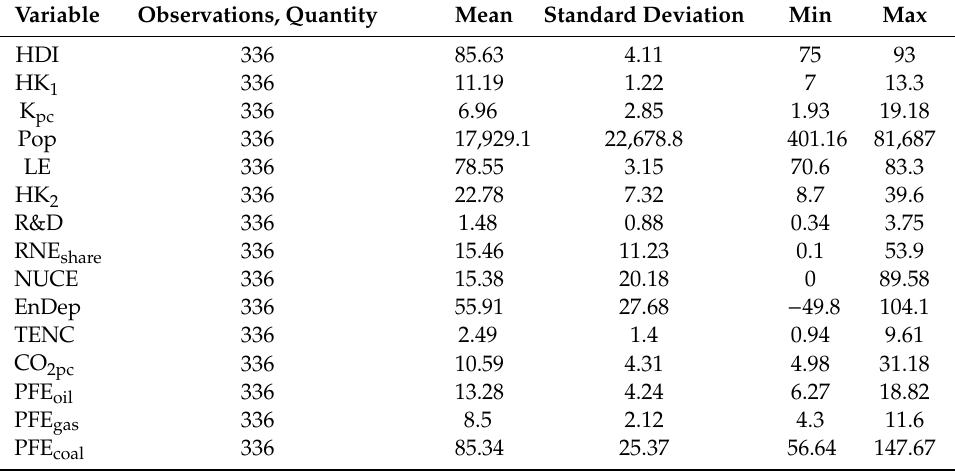
Table 2. Summary statistics of variables used for the model of the relationship between energy consumption, HDI, and the level of sustainable development of state.